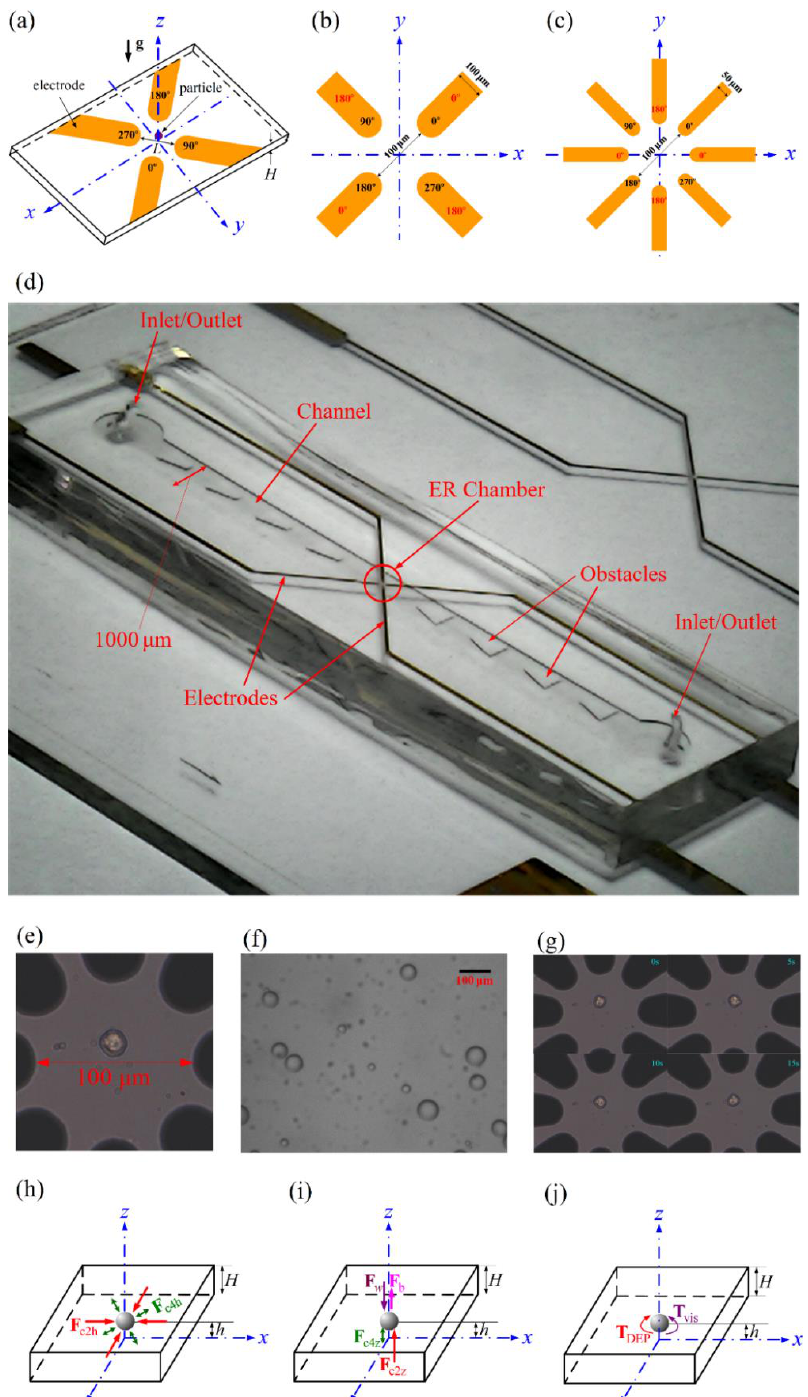
Figure 1. ( a ) Sketch of the electrorotation chamber for measuring K i . g is the gravity. ( b ) Dual frequency signals were applied to the same electrodes for the four-electrode system. ( c ) Dual frequency signals were applied to di ff erent electrodes for the eight-electrode system. ( d ) Device for the four-electrode system. ( e ) A human lung cancer cell, CL1-5, in the test region of the eight-electrode system for experiment. ( f ) Sephadex particles in KCl solution were employed for experimental validation. ( g ) Snapshots from a video for the rotation history of a CL1-5 cell in RPMI solution. ( h ) horizontal force balance of the test particle. ( i ) Vertical force balance of the test particle. ( j ) Torque balance of the test particle for measuring K i . The chamber height, H , is 80 µ